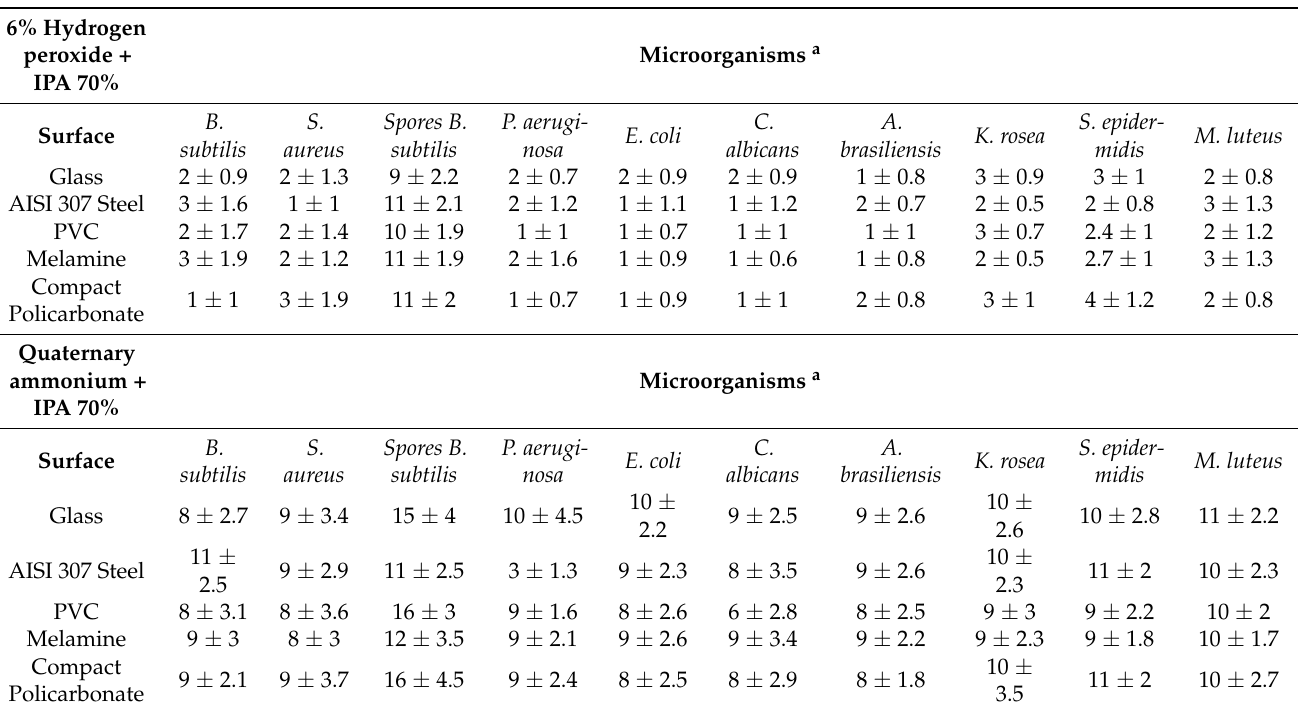
Table 4. Surface contamination determined after disinfection procedure. The tests were performed under practical conditions. For each disinfectant, we used a contact time of 10 min. Each test was done by three operators in triplicate on three surfaces. Each operator worked on different days, for a total of nine replicates. Results are presented as the arithmetic mean of the CFU obtained in the nine samplings ± standard